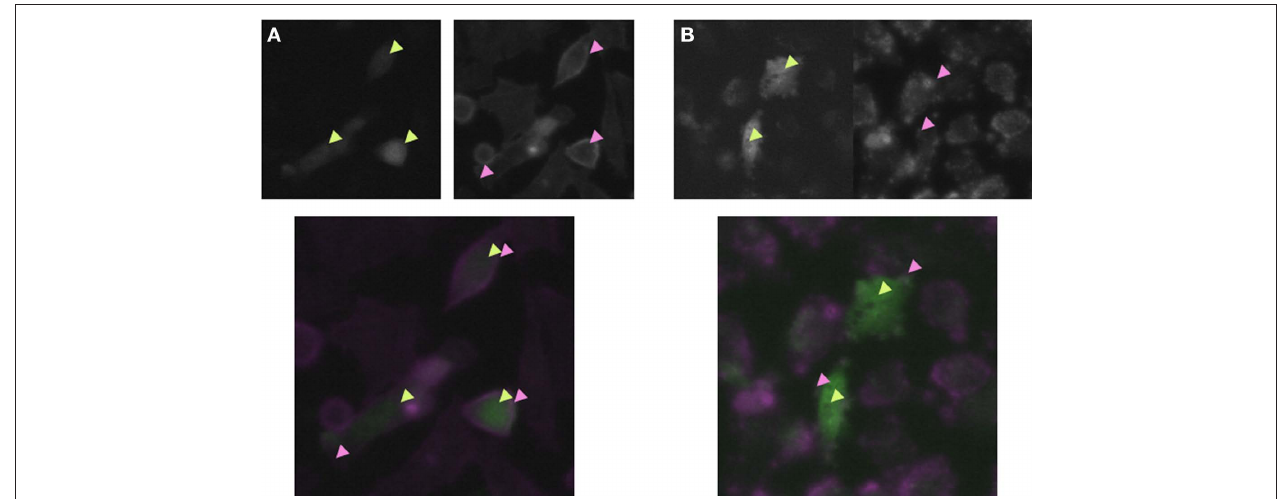
FiguRe A1 | Cytohistochemistry of gFP and actin. Actin proteins observed that they localize at the vicinity of plasma membrane before the treatment [ (A) , upper left panel], and after the CytB treatment, actin proteins aggregated but did not move off from the vicinity of plasmamembrane [ (B) , upper left panel]. On the